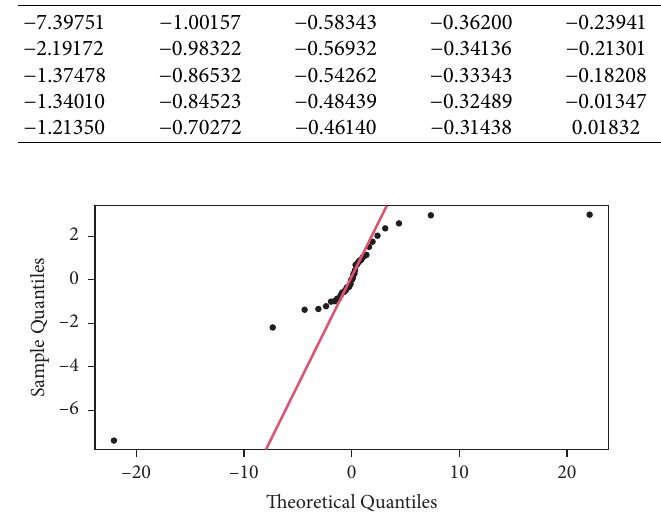
Table 5: Simulated dataset.